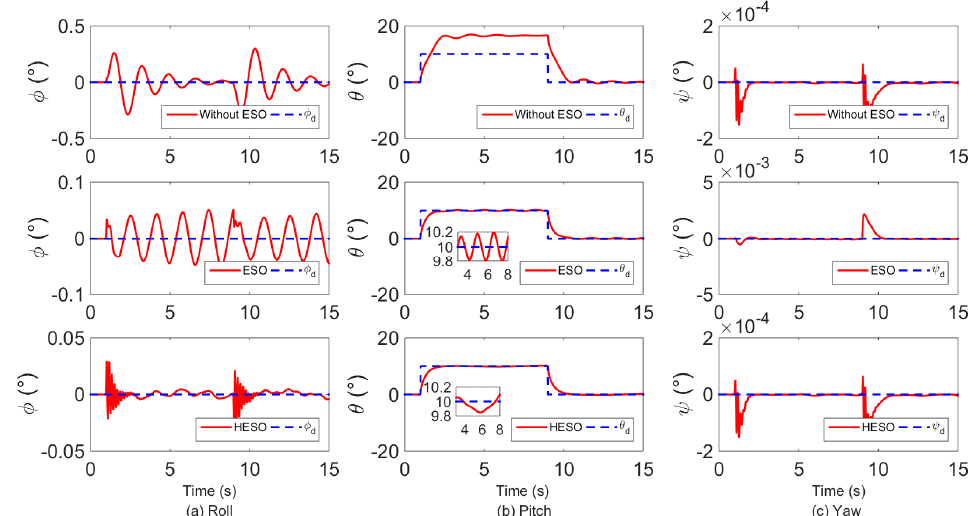
Figure 7. Simulation curves of the attitude angle in attitude tracking: ( a ) roll channel; ( b ) pitch channel; ( c ) yaw channel.